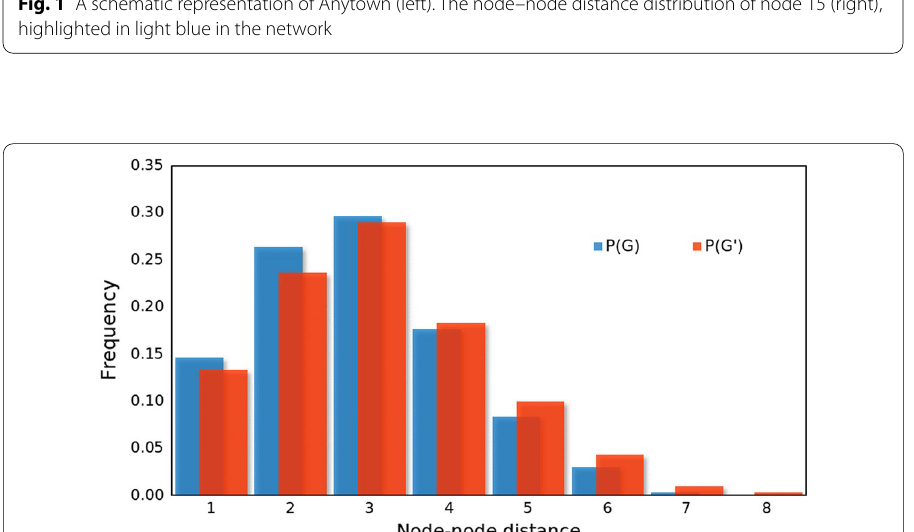
Fig. 2 The node–node distance distributions at network level of G and G